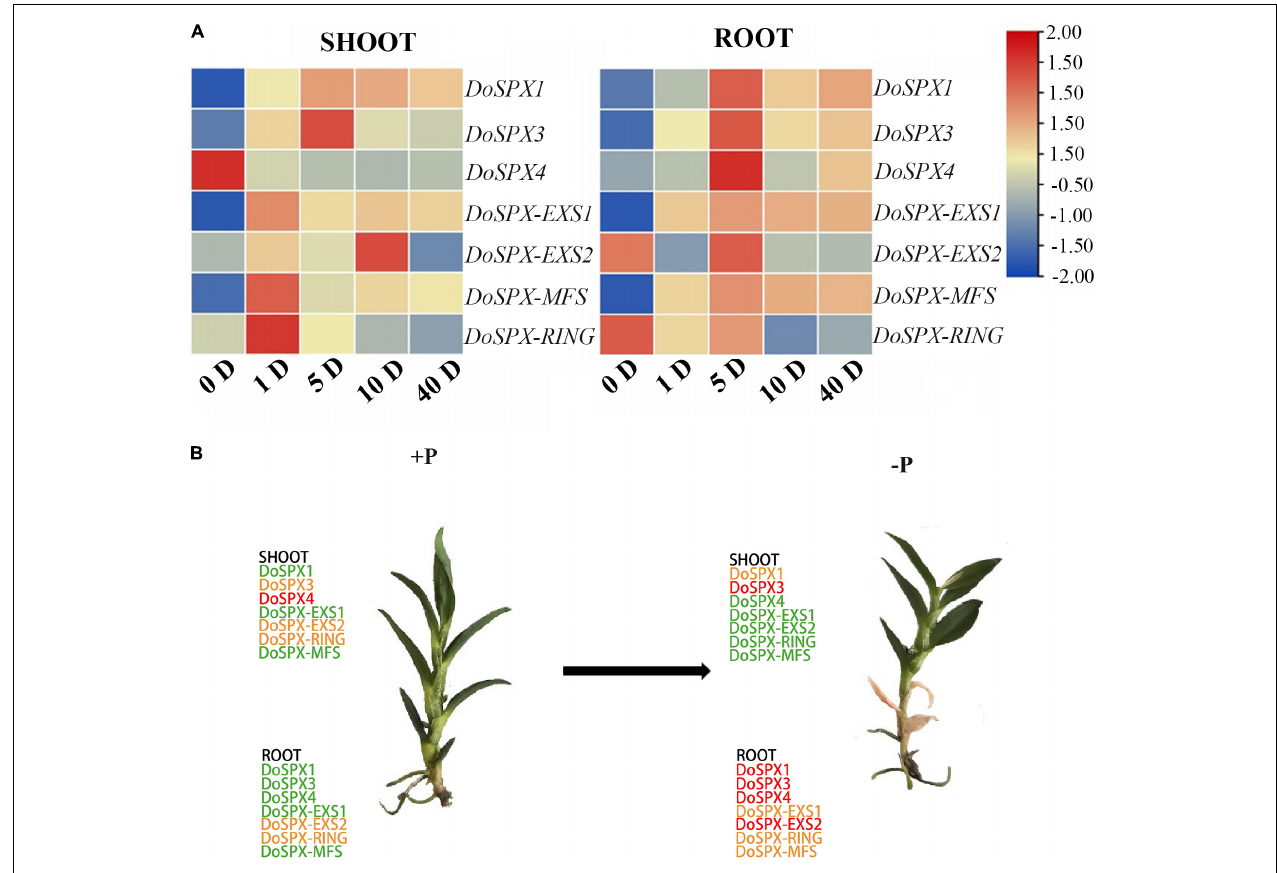
FIGURE 4 | (A) Temporal and spatial expression patterns of PSI gene in shoot and roots under − P stress in D. officinale . The actin was used as an internal reference gene to regulate gene expression (B) SPX genes expression in shoot and root of D. officinale . Treated with − Pi for 5 day. Green, yellow, and red indicate low, medium, and high expression.